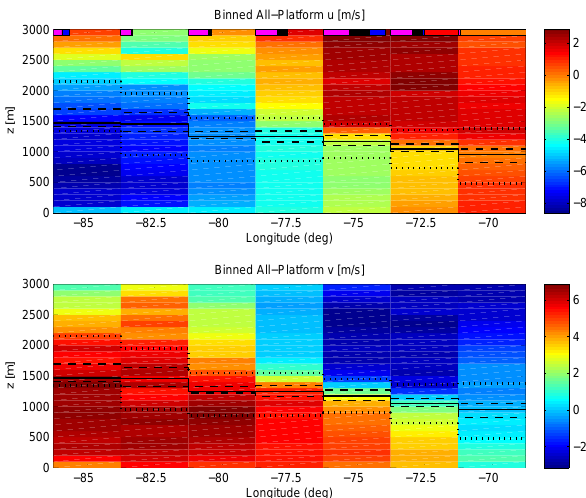
Fig. 7. As in Fig. 5, but for wind components u and v .